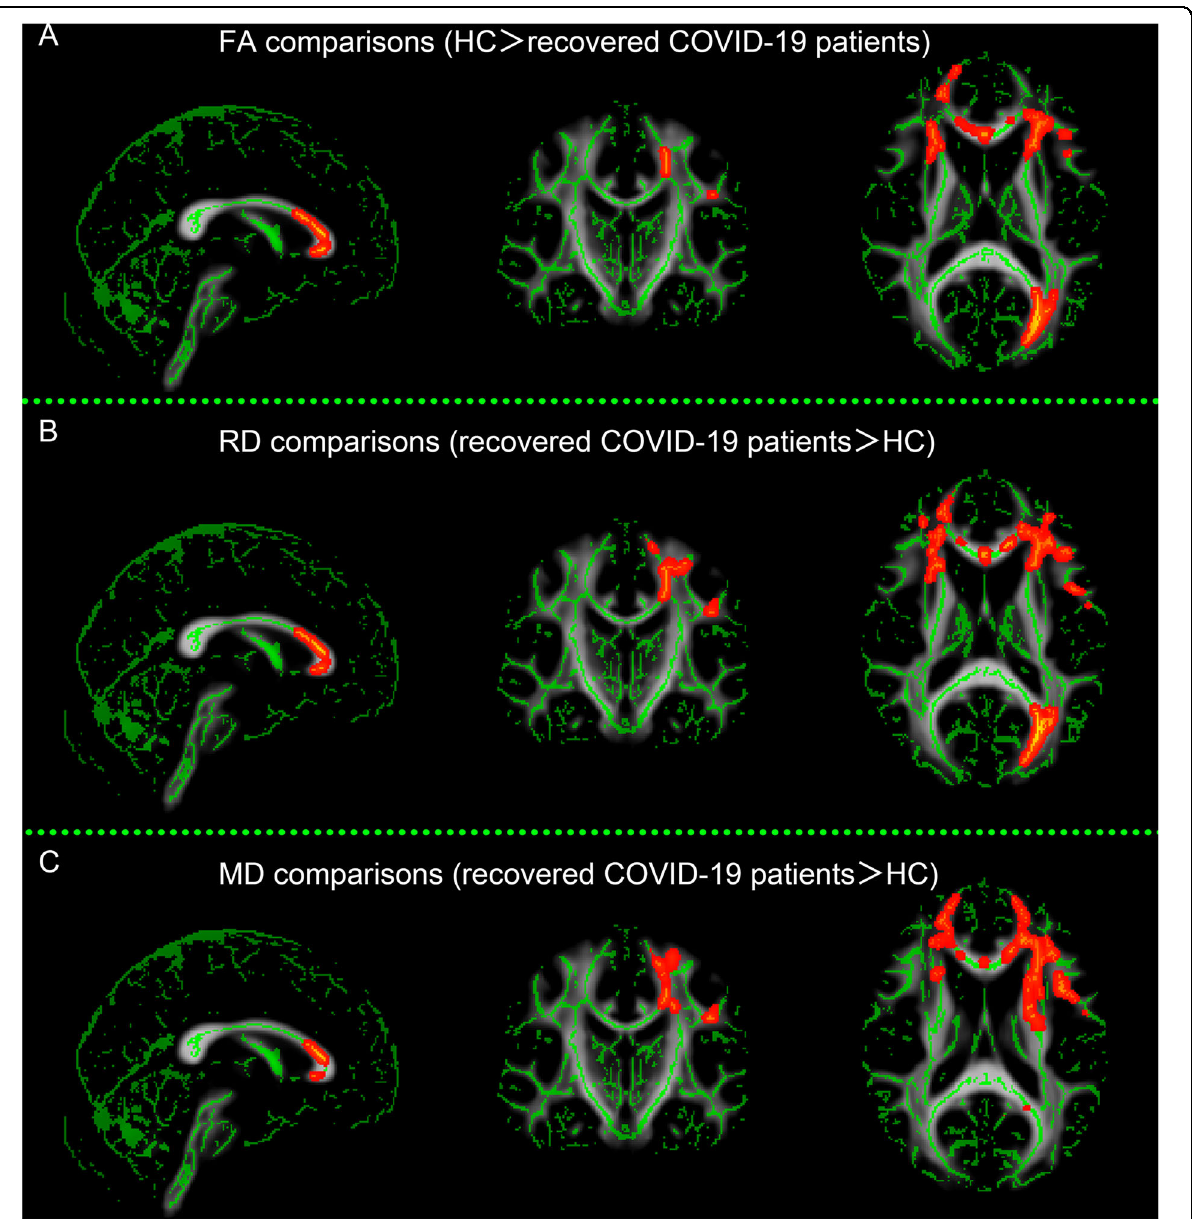
Fig. 1 Differences in the white matter microstructures between recovered COVID-19 patients and healthy controls (HC). Compared with HC, recovered COVID-19 patients showed signi fi cantly decreased fractional anisotropy (FA) ( A ), increased radial diffusivity (RD) ( B ), and increased mean diffusivity (MD) ( C ) in multiple brain regions ( P < 0.05, TFCE corrected), whereas no difference in axial diffusivity (AD) was